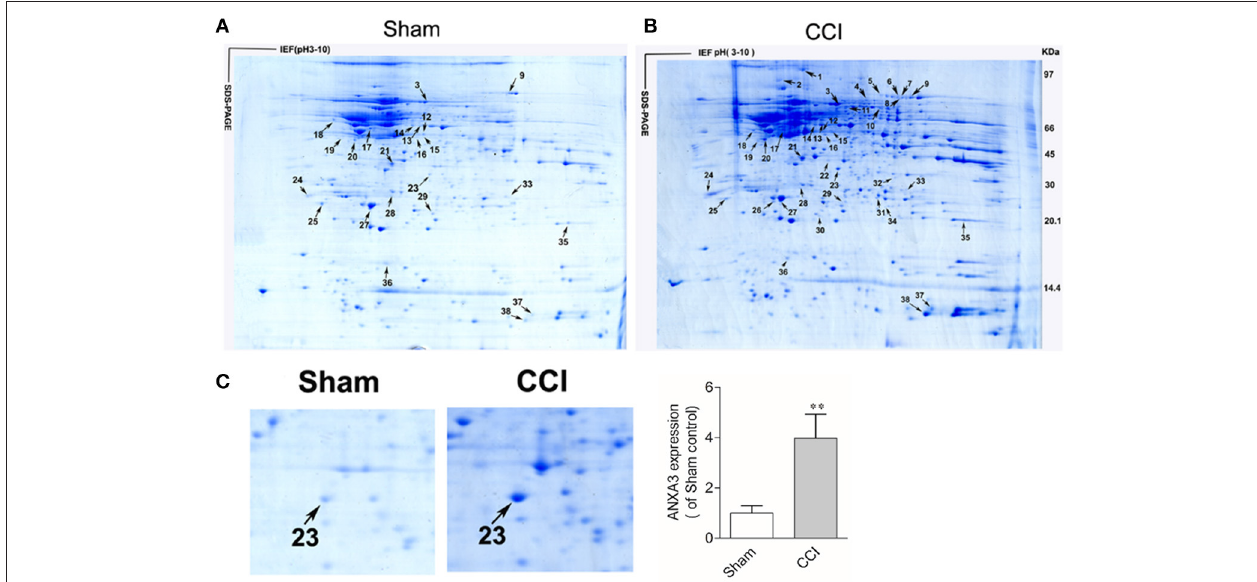
FIGURE 2 | Coomassie brilliant blue G250 stained 2-D gels of spinal cord proteins of the sham (A) , and CCI (B) groups, respectively. Sixteen DEP-spots are marked with arrows. The first dimension, an isoelectric focusing (IEF), was performed with immobilized pH gel (pH 3–10), as indicated on the horizontal axis. The second dimension, SDS-PAGE, was performed with a 9 ∼ 18% SDS polyacrylamide gel, where the proteins are separated by their molecular weight, as indicated on the vertical axis. Arrows refers to MS-identified DEPs. The outcomes are displayed in Table 1 . (C) Close-up image of partial DEP-spots between the sham and CCI groups. (** P < 0.01, n = 4 animals per